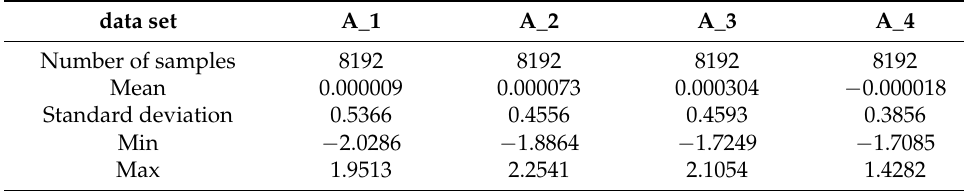
Table 1. Statistical indicators for the four acceleration